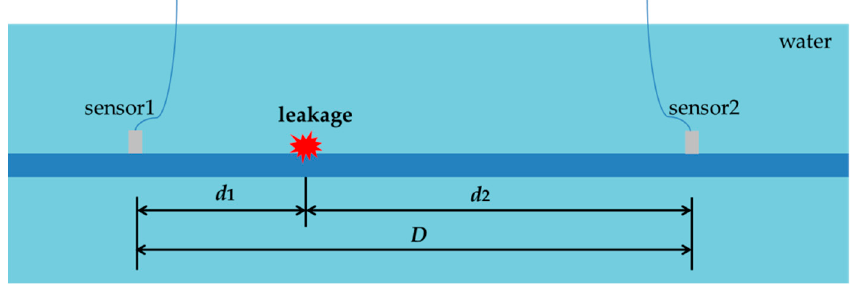
Figure 3. Schematic diagram showing sensor deployment for pipeline leakage detection.